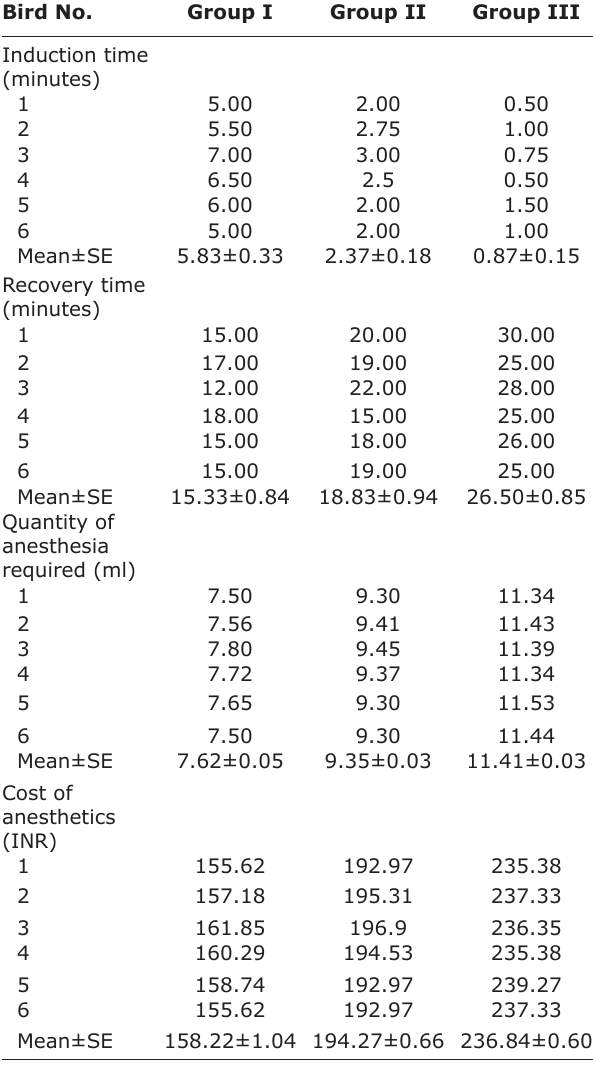
Table-1: Mean±SE of induction time, recovery time, quantity of anesthesia, cost of anesthesia of individual birds. Bird No. Group I Group II Group III Induction time (minutes)